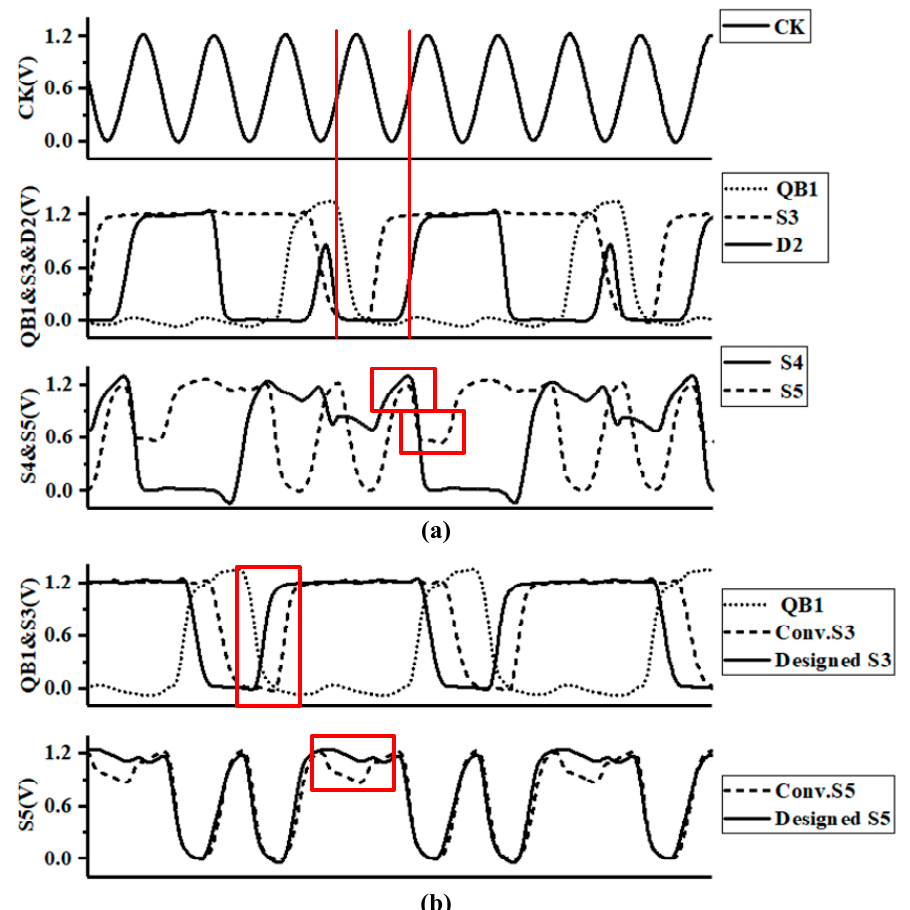
Figure 3. ( a ) Simulated waveforms of the conventional divide-by-2/3 prescaler beyond the maximum operating frequency, ( b ) comparisons of the simulated waveforms of the conventional and designed divide-by-2/3 prescalers.